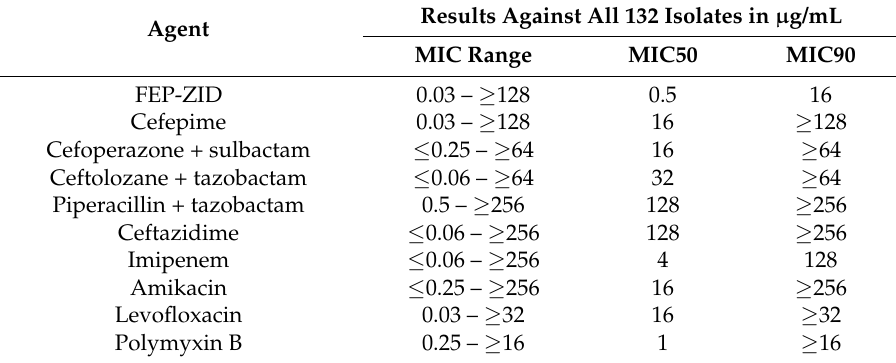
Table 2. Potencies against all